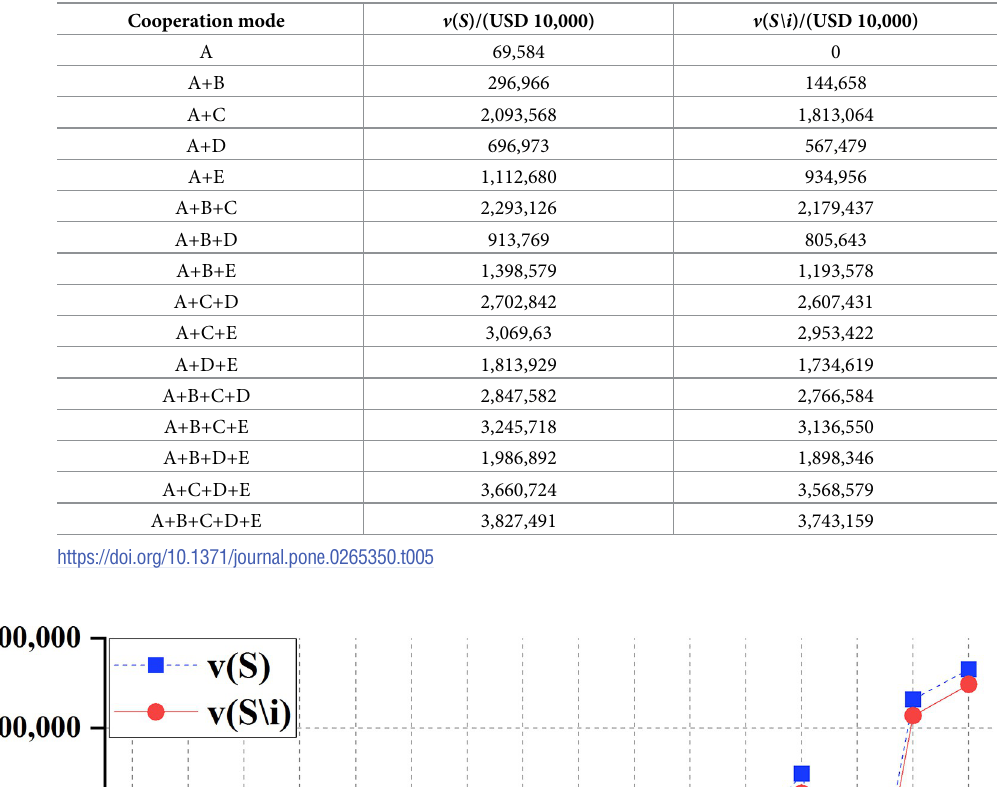
Table 5. Profits of 16 cooperation modes among China and other four countries.